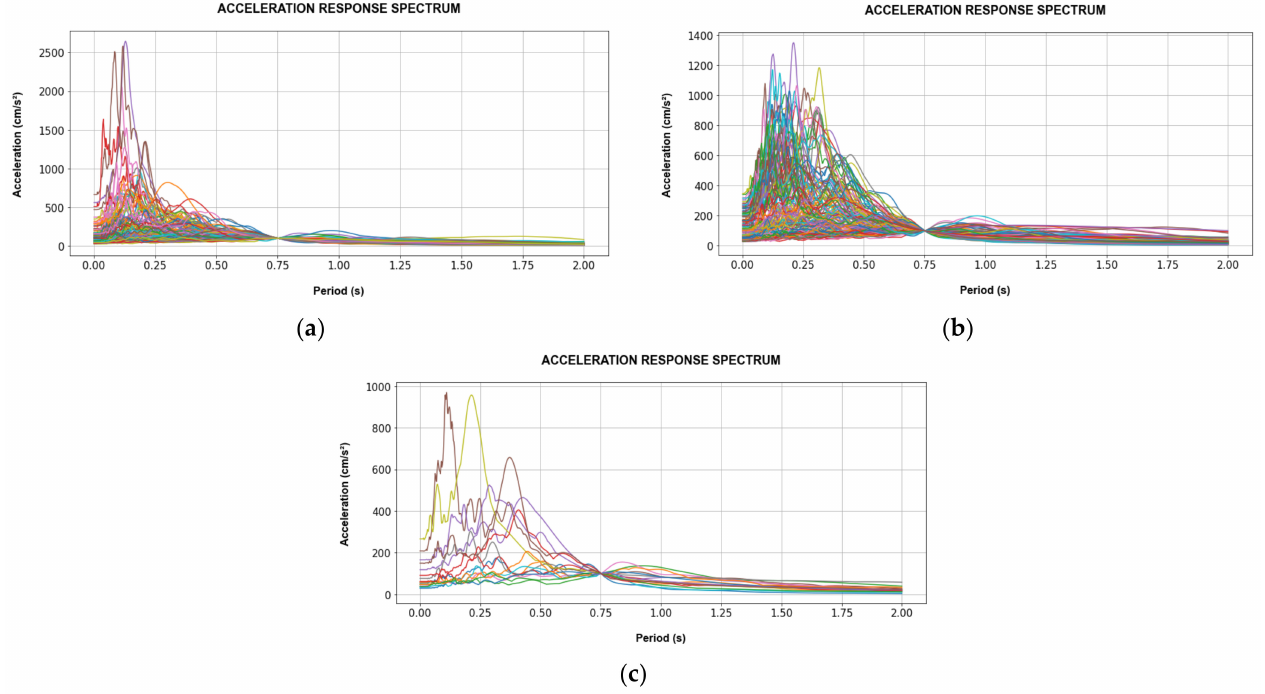
Figure 13. Acceleration response spectrum of Toyohashi Fire Station Building at T 1 = 0.748 s and Sa(T 1 ) = 100 gal. ( a ) Training records for SD; ( b ) training records for AA; ( c ) validation records for SD and AA